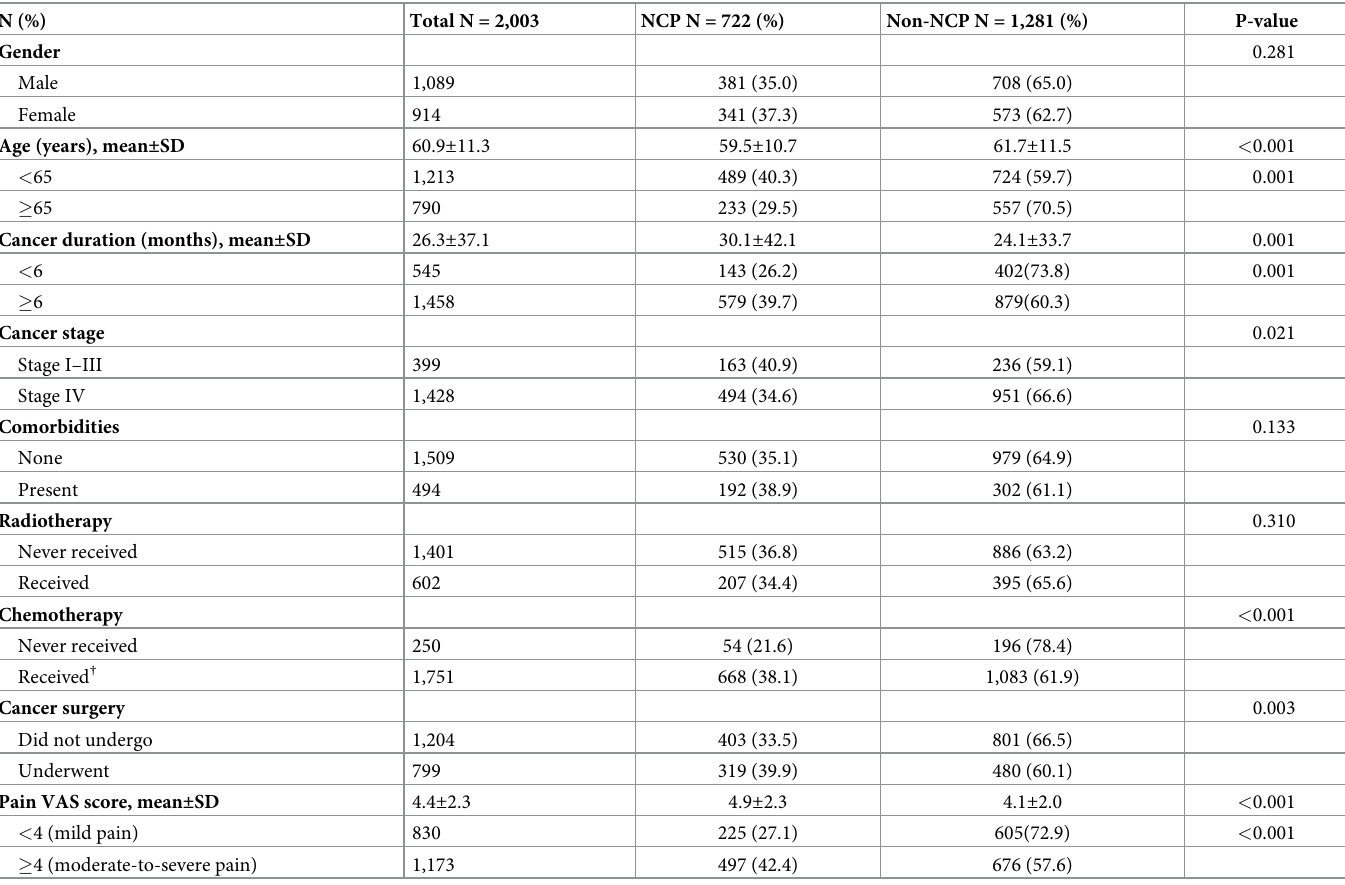
Table 1. Comparison of the characteristics between the NCP and non-NCP groups (N =